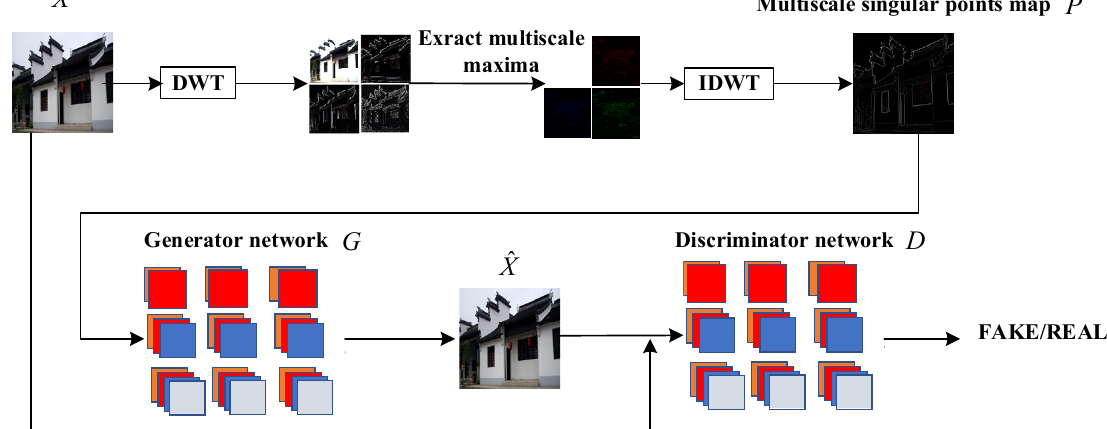
Figure 2. MSCGAN